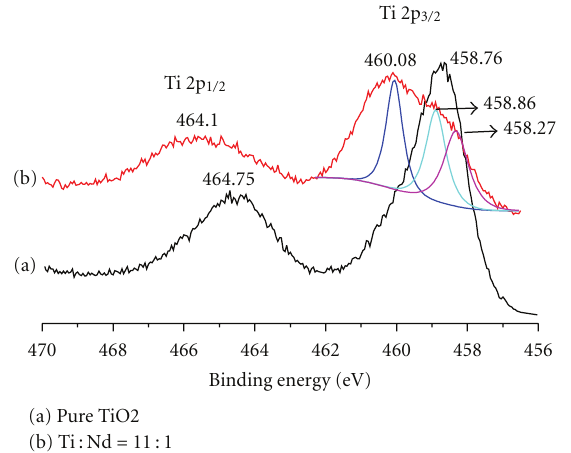
Figure 5: High-resolution XPS spectra of Ti 2p for pure TiO 2 (a) and Nd-doped TiO 2 with Ti: Nd = 11: 1 (b).